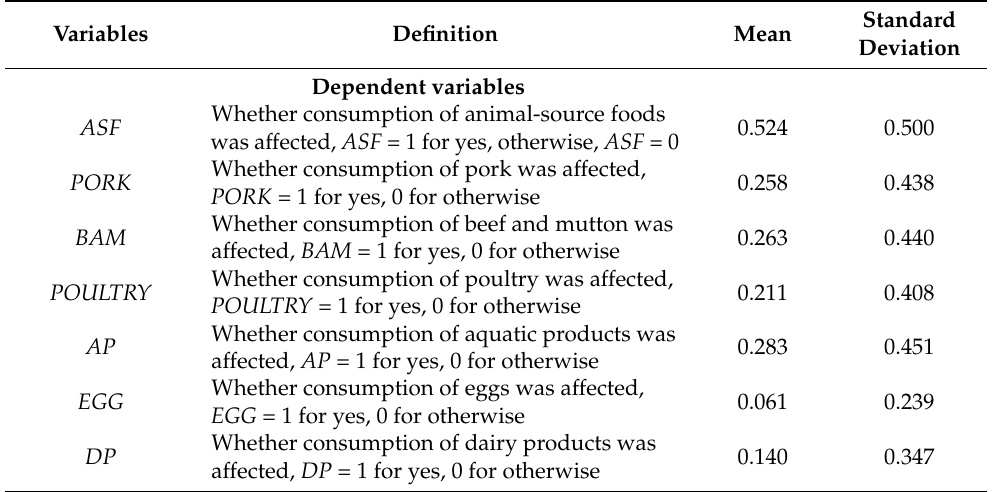
Table 1. The dependent variables used in this